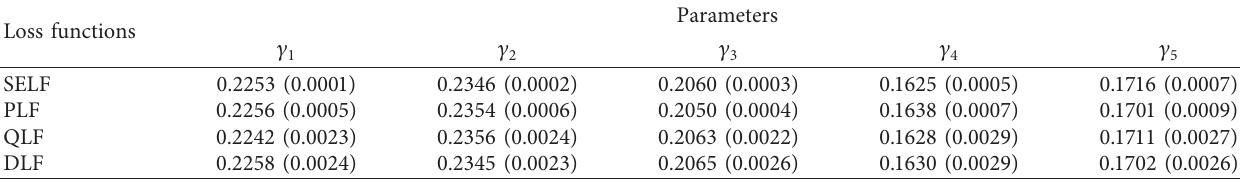
Table 3: Bayes estimates (BEs) and posterior risks (PRs) using Jeffreys prior.